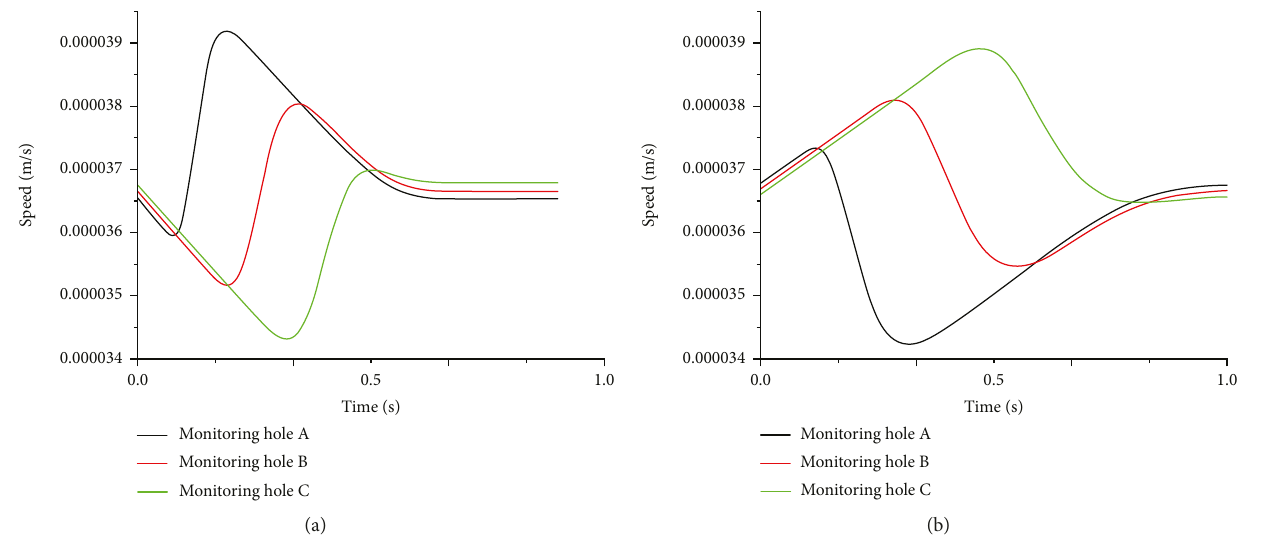
Figure 7: The velocity curve at the outlet in di ff erent injection directions when the injection rate is 2 mL/min: (a) gravity direction and (b) reverse gravity direction.